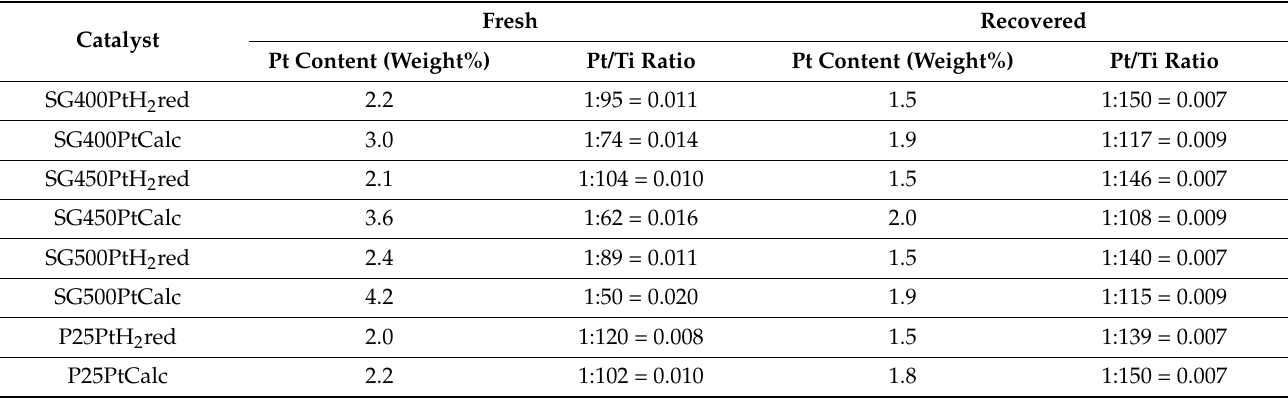
Table 2. Quantitative analysis of the Pt content obtained from X-ray photoelectron spectroscopy (XPS) data of the fresh and recovered catalyst